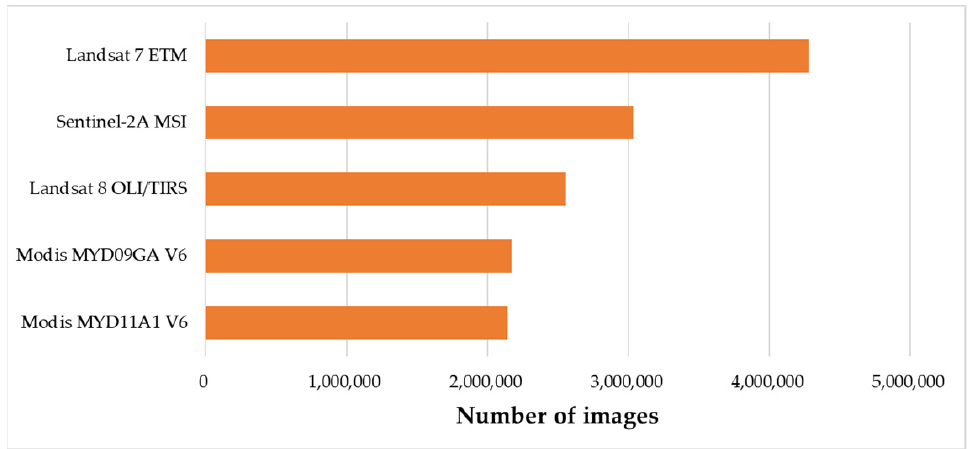
Figure 23. Number of remote sensing images from different sources.